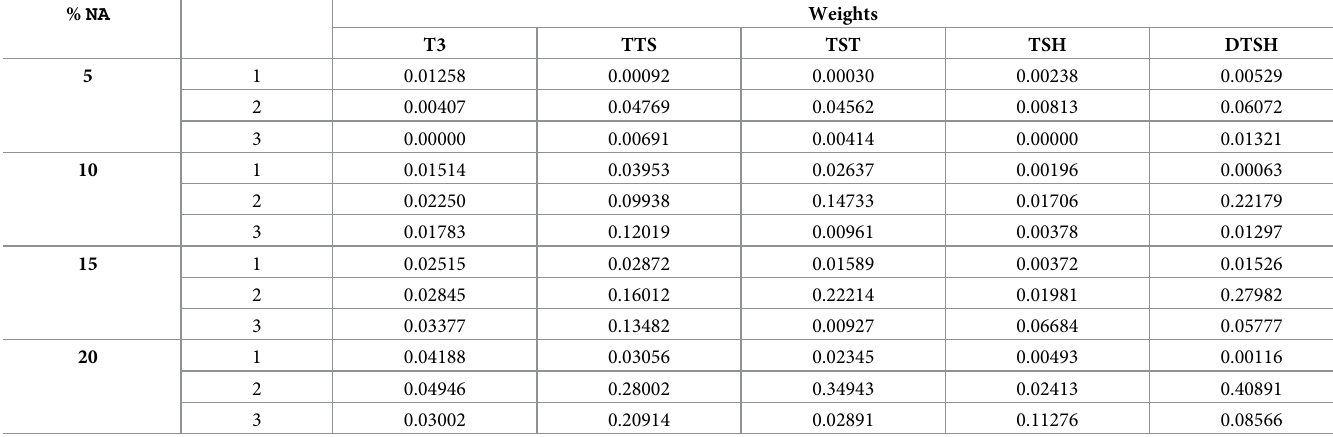
Table 12. Consistencies of variables for the Thyroid Gland dataset.